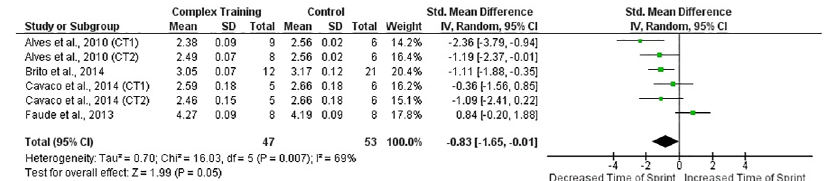
Fig 4. Standardized mean difference (SMD) in post-intervention sprint time between CT-trained and control subjects. Squares represent the SMD a for each trial. Diamondsrepresentthe pooledSMD across trials.